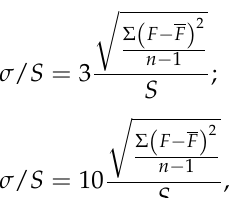
Figure S1: Evolution of the fluorescence spectrum of 7-dimethylaminocoumarin oxime 1 in MeCN after F − anion and subsequent water addition; Figure S2: Evolution of the fluorescence spectrum of 7-dimethylaminocoumarin oxime 1 in DMF after F − anion and subsequent water addition; Figure S3: Evolution of the fluorescence spectrum of 7-coumarin oxime 2 in MeCN after F − anion and subsequent water addition; Figure S4: Evolution of the fluorescence spectrum of coumarin oxime 2 in DMF after F − anion and subsequent water addition; Figure S5: Evolution of the emission spectrum of 7-coumarin oxime 1 in MeCN during 1 solution titration with TBA + F; Figure S6: Evolution of the emission spectrum of coumarin oxime 2 in MeCN during 2 solution titration with TBA + F − ; Figure S7: Evolution of fluorescence decay of 7-coumarin oxime 1 in MeCN during 1 solution titration with TBA + F − ; Figure S8: 1 H NMR spectrum of 7-dimethylaminocoumarin oxime 1 in DMSO- d 6 before and after F − anion (TBA + F − ) and subsequent water addition; Figure S9: 1 H-NMR spectrum of coumarin oxime 2 in DMSO-d 6 before and after F − anion (TBA + F − ) and subsequent water addition; Figure S10: Geometries of oxime 1 /oximate 1 stable conformers optimized at the M06-2X/6-31+G(d,p) level of theory; Figure S11: Poly(propylene carbonate) thin polymer films of pure 7-dimethylaminocoumarin oxime 1 and two-component 7-dimethylaminocoumarin oxime 1 /F − system on teflon plate; Figure S12: Transient absorption spectrum of oximate 1 in MeCN, Table S4: Excitation energies, oscillator strengths ( f ) and orbital contributions to corresponding electronic transitions from ground state (S 0 ) of studied coumarin oxime 1 ; Figure S13: Frontier molecular orbitals of 7-dimethylaminocoumarin oxime 1 ; Figure S14: Fluorescence intensity behaviour of studied two-component coumarin oxime sensor 1 /F − in DMF during titration with water; Figure S15: